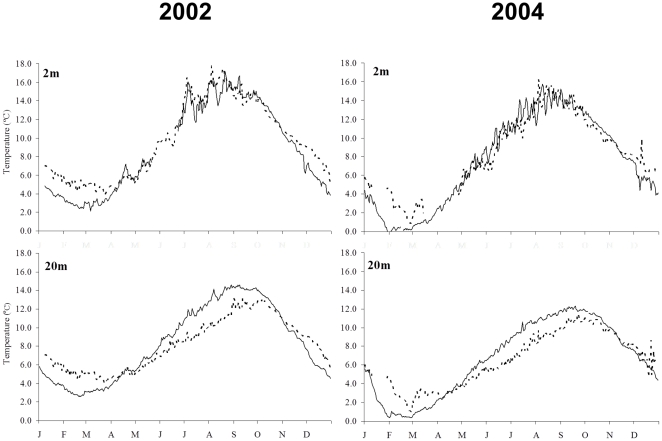
Bottom water temperatures in mid-coast Maine.Mean daily temperature data collected at MI and from Penobscot Bay (proxy for GI) from 2002 and 2004. Temperature was collected at depths of 2 and 20 m by the Gulf of Maine Ocean Observing System and are available at www.gomoos.org.